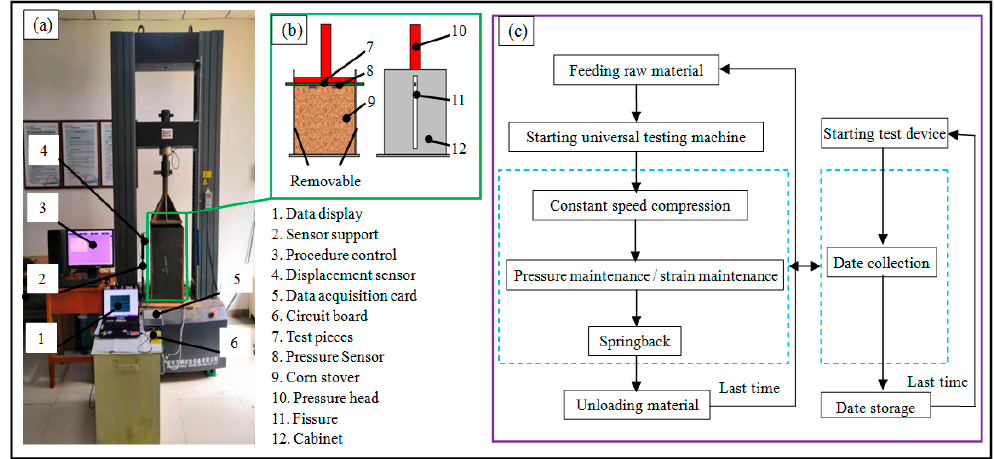
Figure 1. Instruments and procedures. ( a ) The straw compression and test system; ( b ) magnified figure; ( c ) compression procedure.